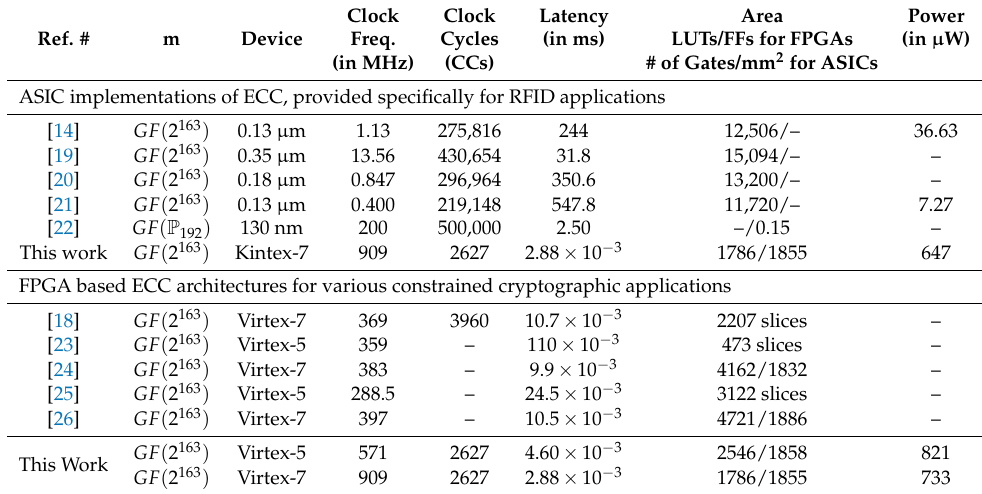
Table 2. Comparison to state-of-the-art ECC-based accelerator architectures. Ref.